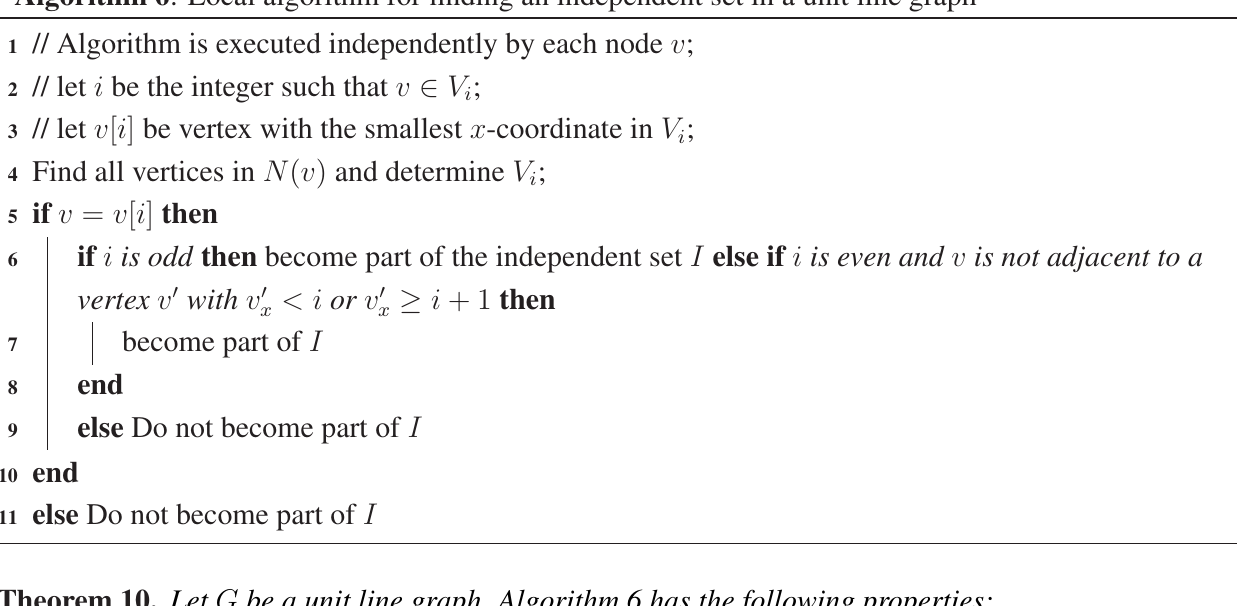
Algorithm 6 : Local algorithm for finding an independent set in a unit line graph // Algorithm is executed independently by each node v ;